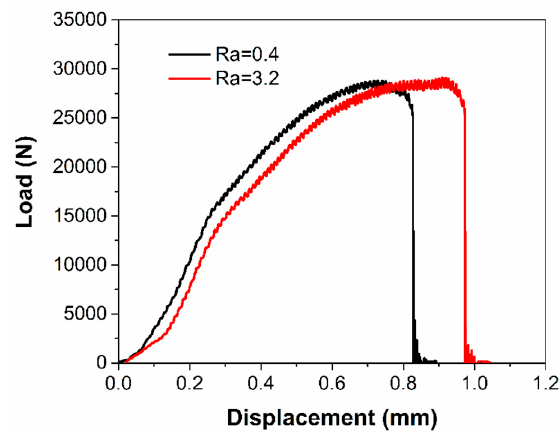
Figure 10. Shear load versus displacement over two roughness substrates.